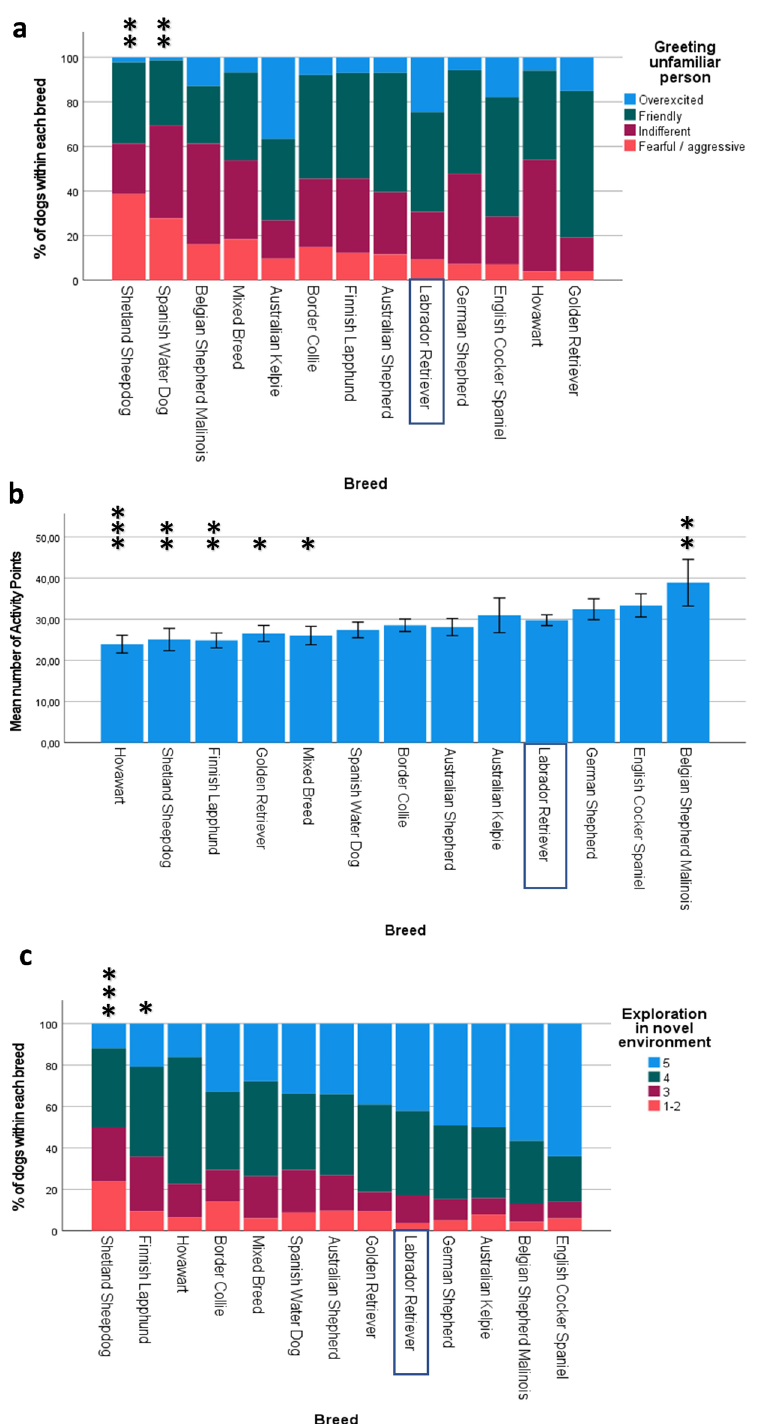
Figure 1. Breed differences of greeting unfamiliar person, activity level, and exploration in novel environment. Significant P-values (Bonferroni-corrected) are indicated with asterisks: ***p ≤ 0.001, **p ≤ 0.01, *p ≤ 0.05. The Labrador Retriever was used as the reference breed. ( a ) Percentage of dogs within each breed receiving each of the four greeting scores (n = 934). Breeds have been ordered based on odds ratios, from most fearful (highest odds ratio for score 1–3) on the left to least fearful (lowest odds ratio for score 1–3) on the right. P-values have been indicated for fearful response using asterisks. ( b ) Mean activity level scores (measured in FitBark activity points) for each breed (N = 759). Error bars represent 95% confidence intervals. Breeds are ordered based on B-values, with lowest activity levels on the left and highest activity levels on the right. ( c ) Percentage of dogs within each breed with each exploration score (N = 820). Breeds are ordered based on B-values, with lowest exploration on the left and highest exploration on the right. Score 1–2: low investigation (stays close to owner). Score 3: moderate investigation. Score 4: active investigation (walking). Score 5: very active investigation